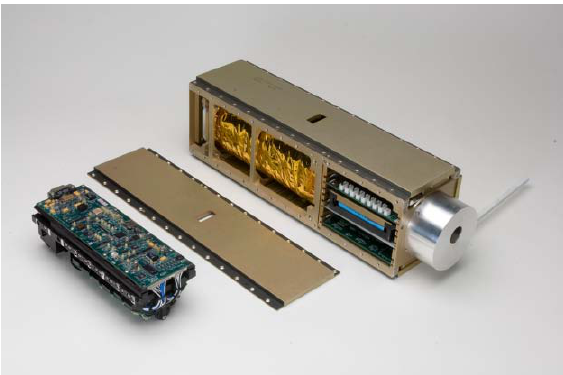
Figure 2. CAD Model of CanX-2 CubeSat [12].